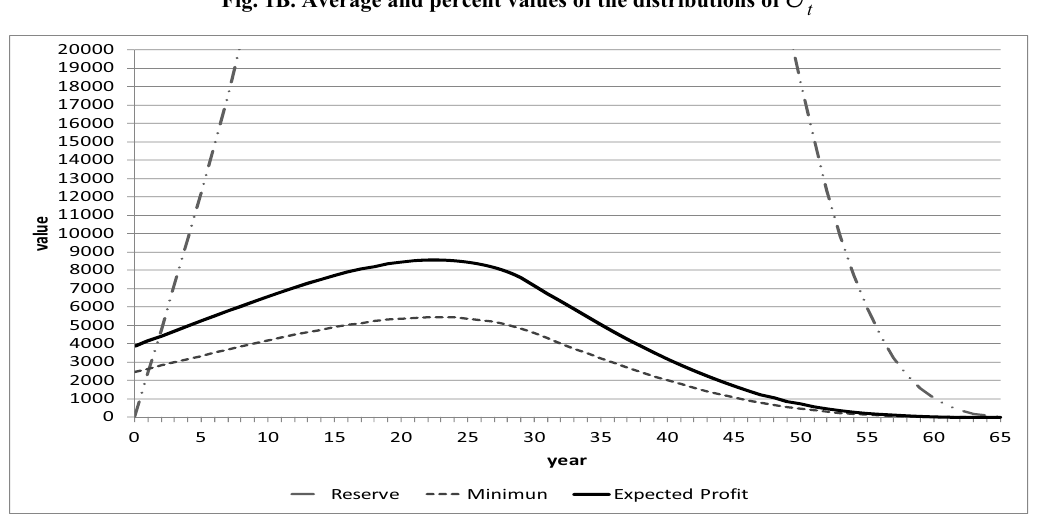
(cid:5) U and of the generation full t